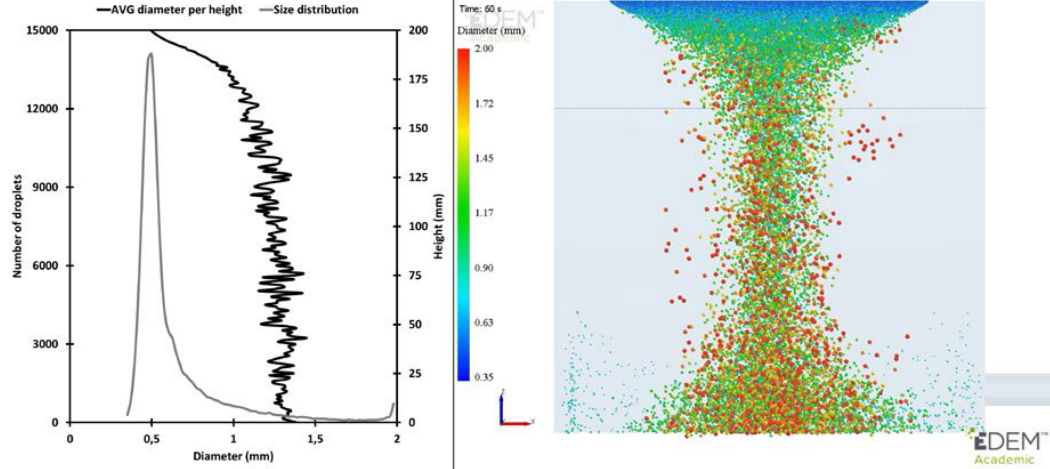
Figure 7. Average velocity of droplets and calculated velocity.